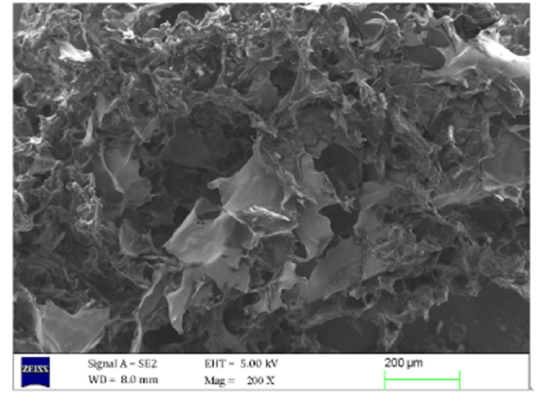
Figure 5. SEM micrographs of Glu-Cys-SAs gel.